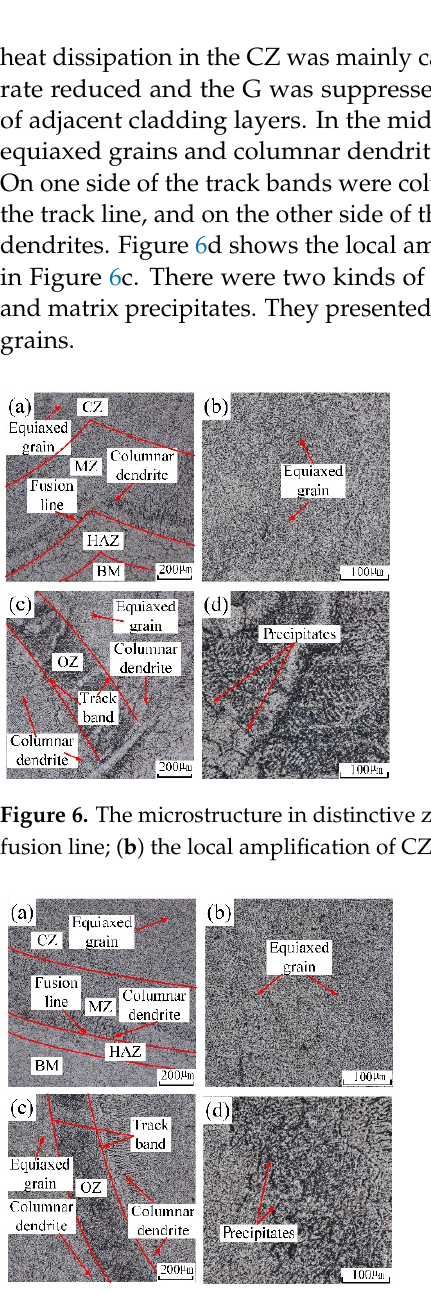
Figure 7. The microstructure in distinctive zones of underwater cladding layer: ( a ) the microstructure near fusion line; ( b ) the local amplification of CZ; ( c ) OZ; ( d ) the local amplification of OZ.